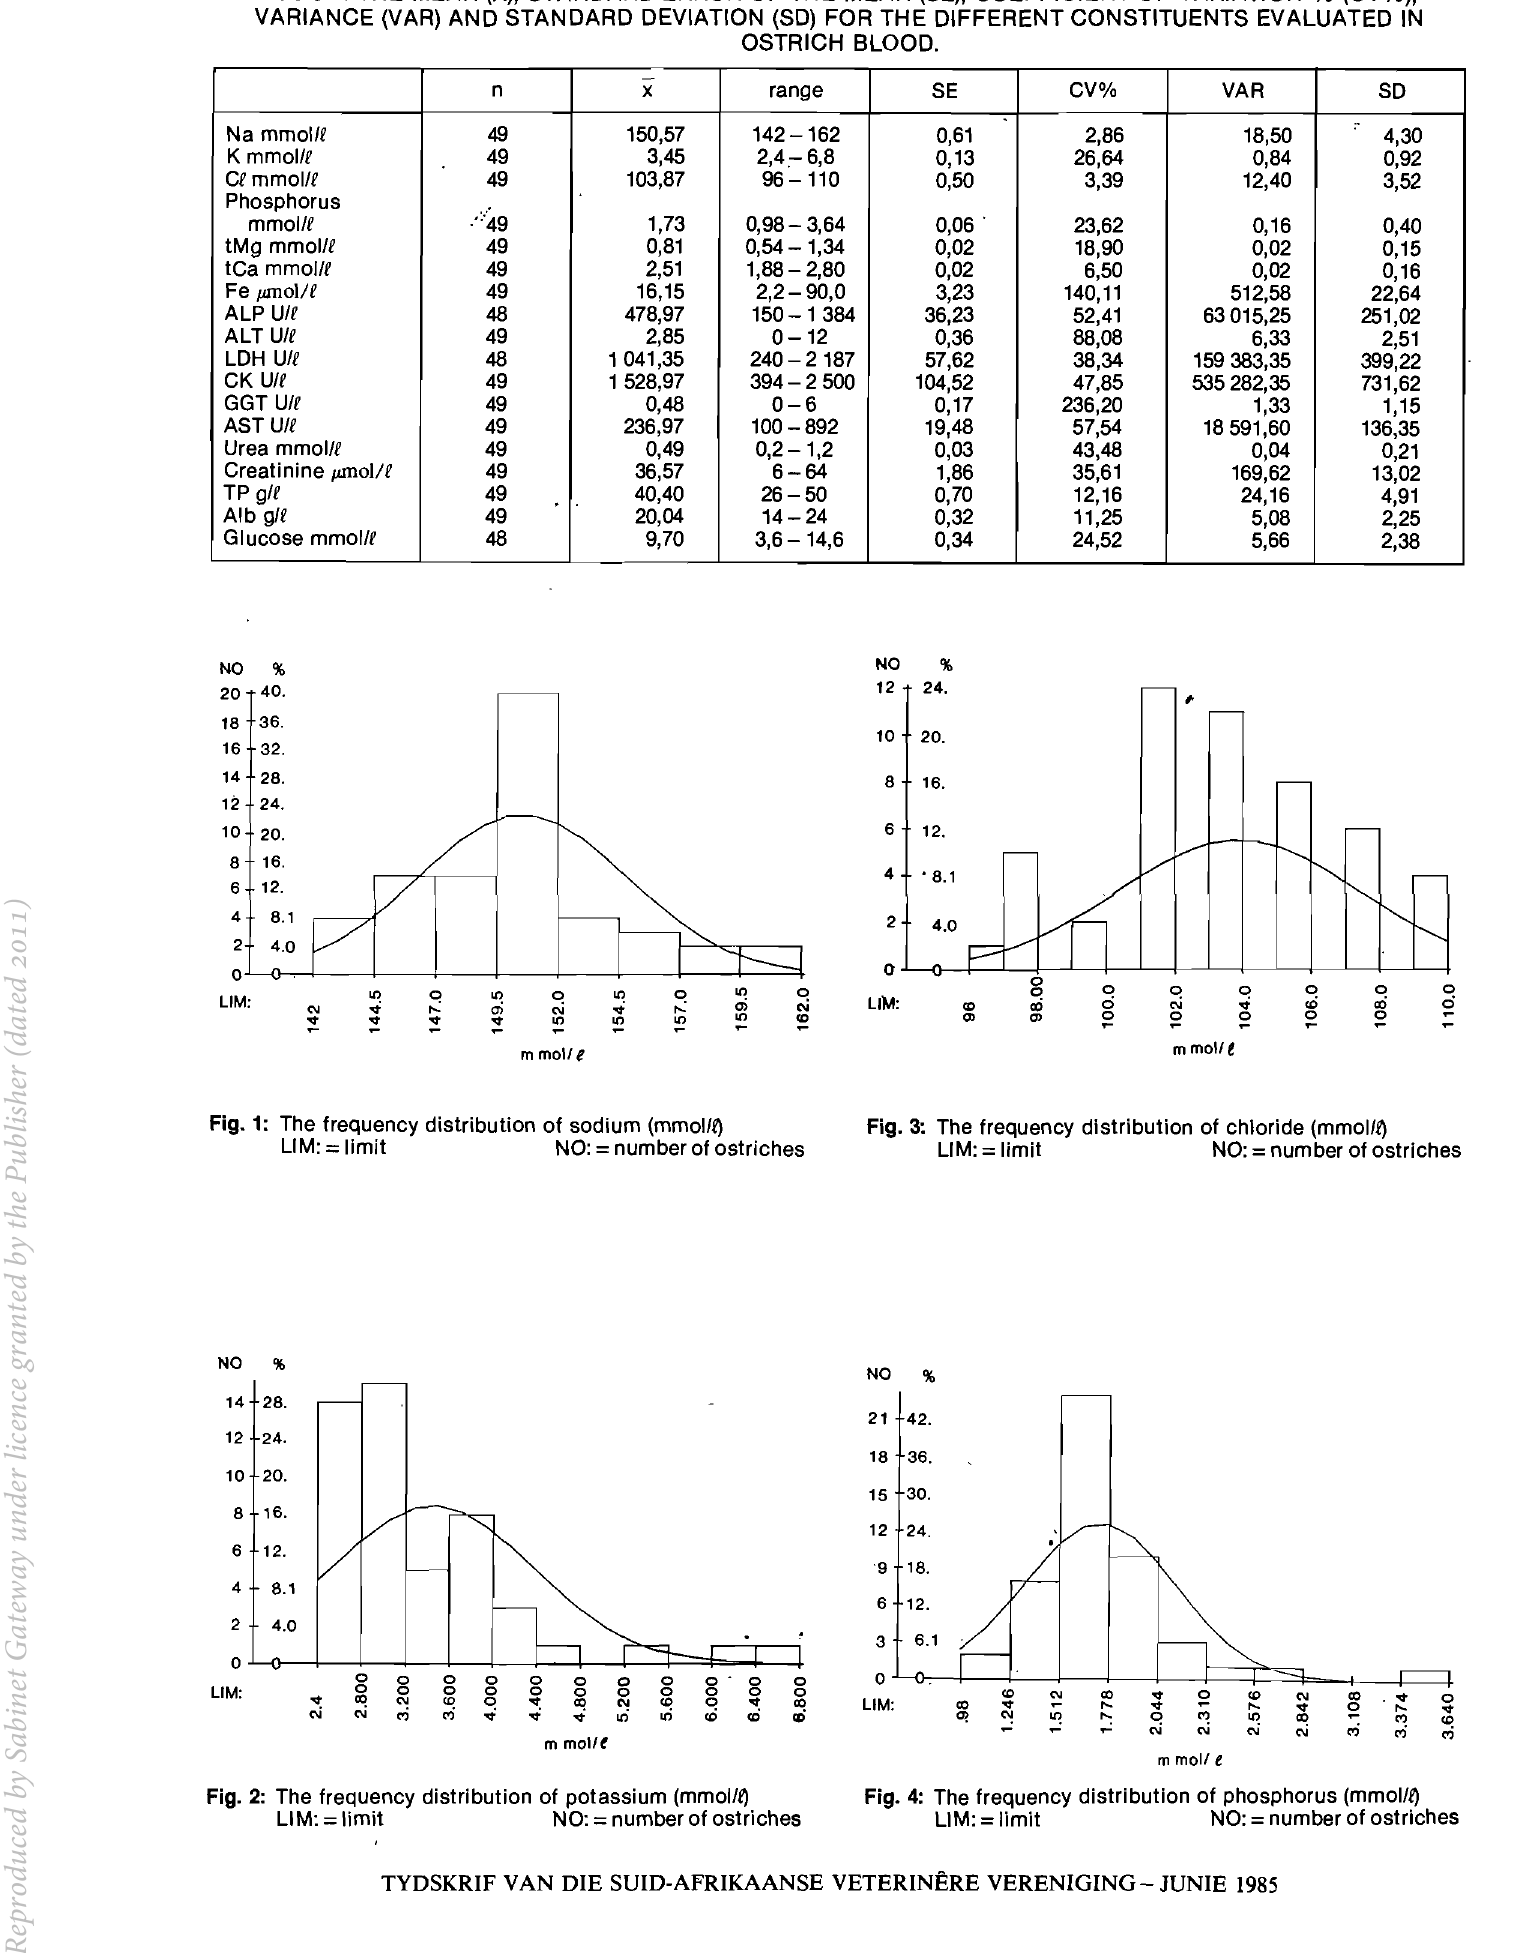
Table 1: THE MEAN (5<), STANDARD ERROR OF THE MEAN (SE), COEFFICIENT OF VARIATION % (CV%), VARIANCE (VAR) AND STANDARD DEVIATION (SD) FOR THE DIFFERENT CONSTITUENTS EVALUATED IN OSTRICH BLOOD.